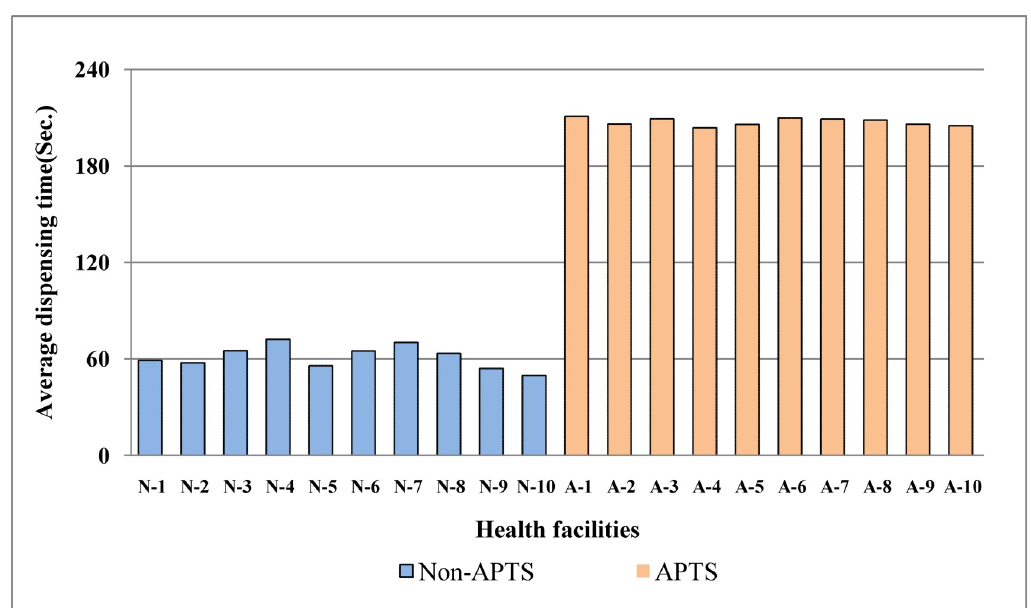
Fig 5. Average dispensing time in seconds between APTS and non-APTS facilities. N: Non-APTS facilities, A: APTS facilities.